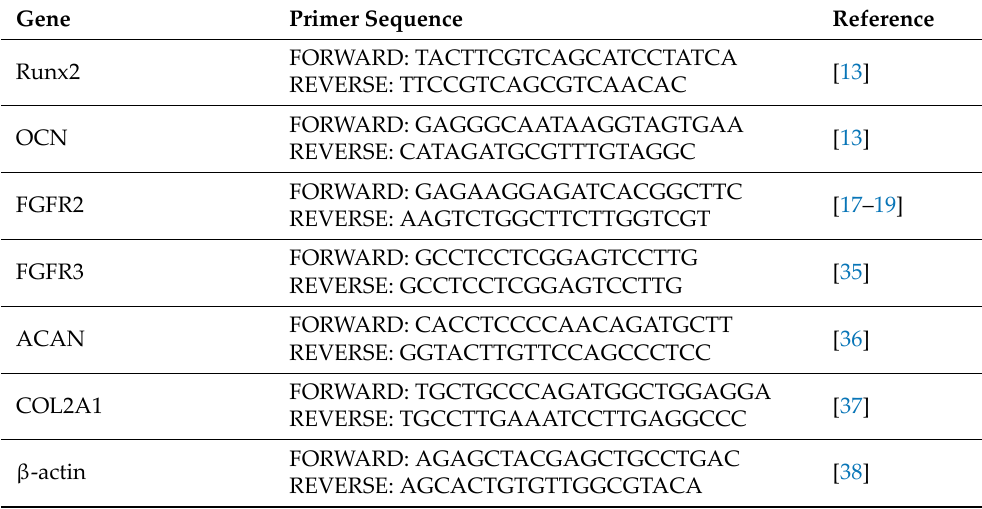
Table 2. Primer sequences for RT‑qPCR of target genes. Gene Primer